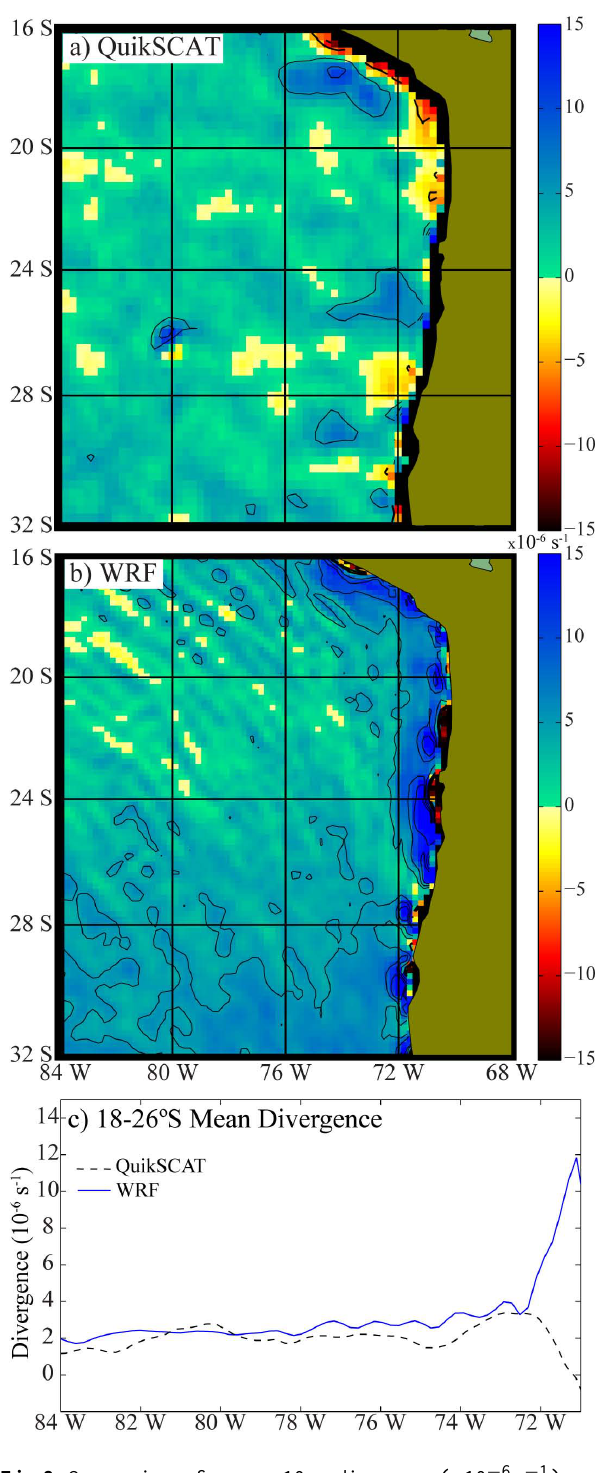
Fig. 8. Comparison of average 10-m divergence ( × 10 − 6 s − 1 ) over October and November 2008 from (a) QuikSCAT, (b) WRF, and (c) mean divergence between 18–26 ◦